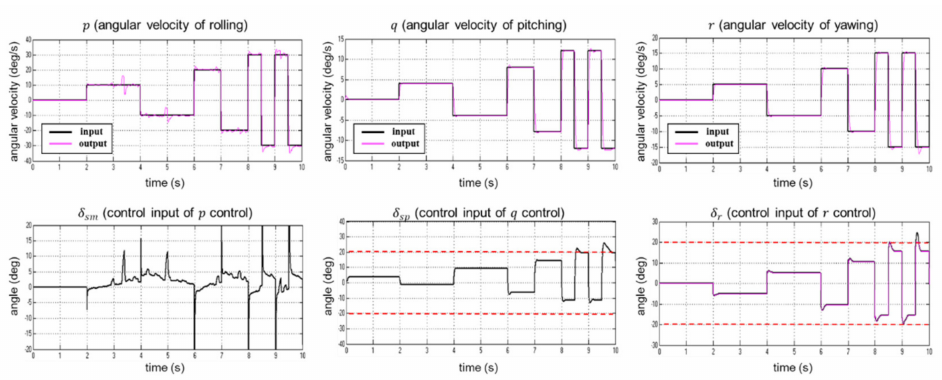
Figure 7. Small and large disturbances.